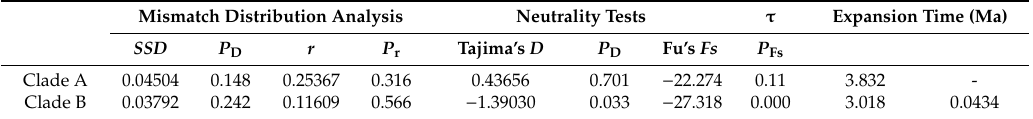
Figure 5. Demographic expansion models for two major clades of P. glacialis . ( A ) Mismatch distribution analyses for Clades A and B. The blue dotted and brown solid lines represent the observed and expected mismatch distributions of a stationary population, respectively; ( B ) Bayesian skyline plots for Clades A and B. The X -axis represents time (Ma) and the Y -axis is Ne × μ (effective population size × mutation rate per site per generation). Medians are shown as solid lines, and gray areas represent 95% HPD limits. Table 4. Mismatch distribution analysis and neutrality test results for Clades A and B.